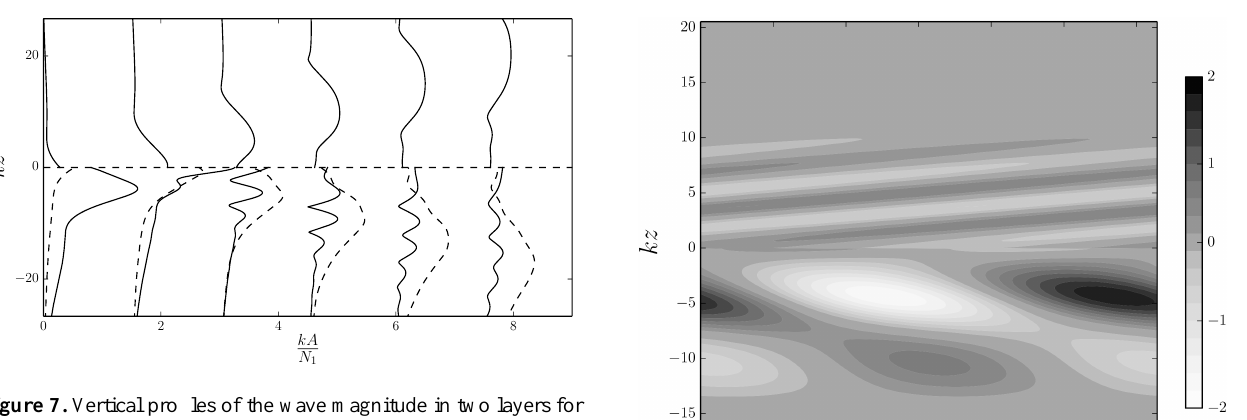
Figure 7. Vertical profiles of the wave magnitude in two layers for a sequence of times. Each profile is shifted by a value of 1.5 for dis- play. The parameter values are n 1 /k = 0.4, N 2 /N 1 = 2, (cid:15) = 0.025, and α = 0.1. The line conventions are the same as Fig. 3.